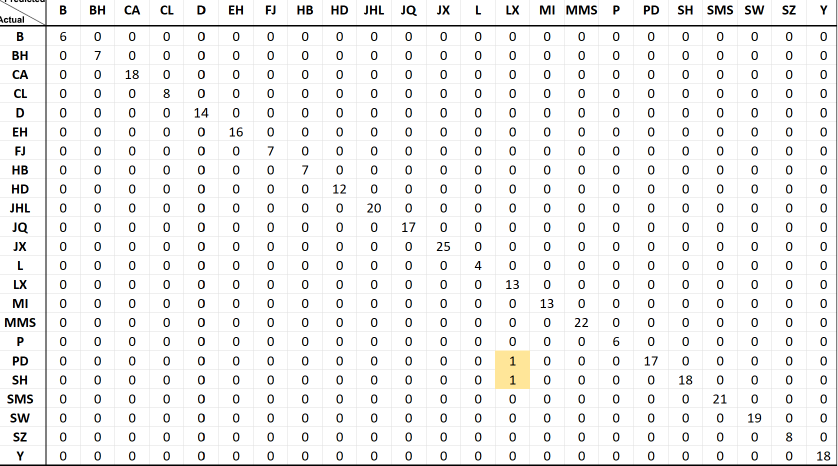
Figure 5. Validation of the established random forest model using the test set. The first header row shows the breeds predicted by the model for the classification of the 318 individuals in the RF test set, and the first column shows the actual observed classification of the breeds for the 318 individuals. The results show that, in each of the PD and SH breed, only one sample classification is inconsistent with the actual observed results (marked with a yellow background) On the other hand, we counted the distribution of SNPs on chromosomes in the 1K SNP panel and the 100 SNP panel by the MDA measure selected, where the 1K panel had a better coverage on chromosomes. For example, it has at least 20 SNPs on chromosome 10 (Figure 6). On the contrary, the 100 SNPs, due to the substantially reduced number,